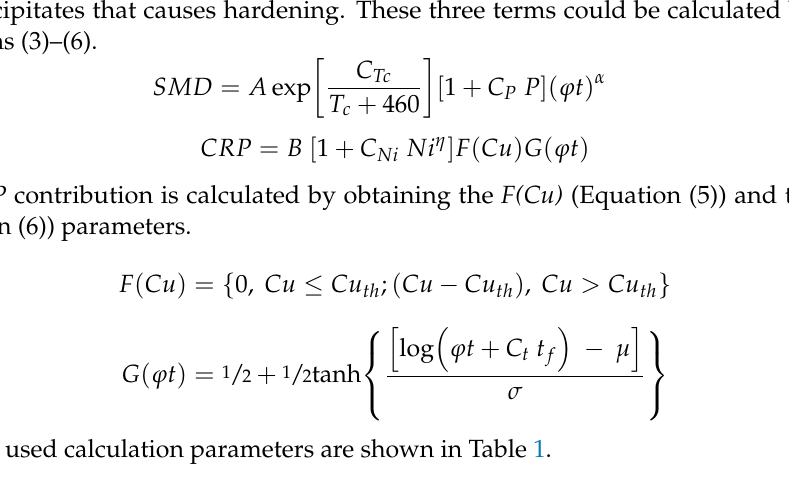
Table 1. Parameters used in the SMD and CRP calculation according to ASTM E900-02 model